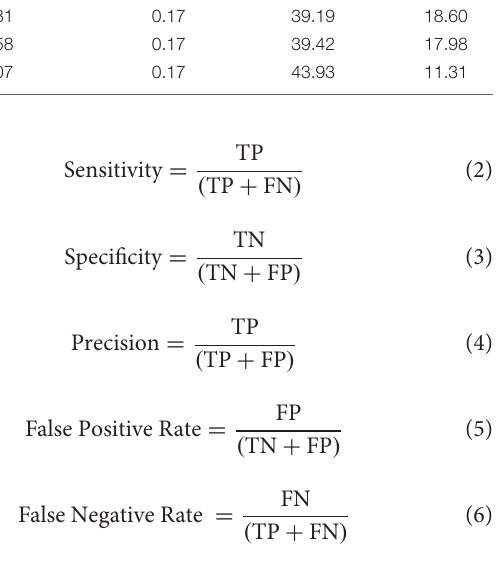
TABLE 3 | Accuracy metrics for models (test dataset).